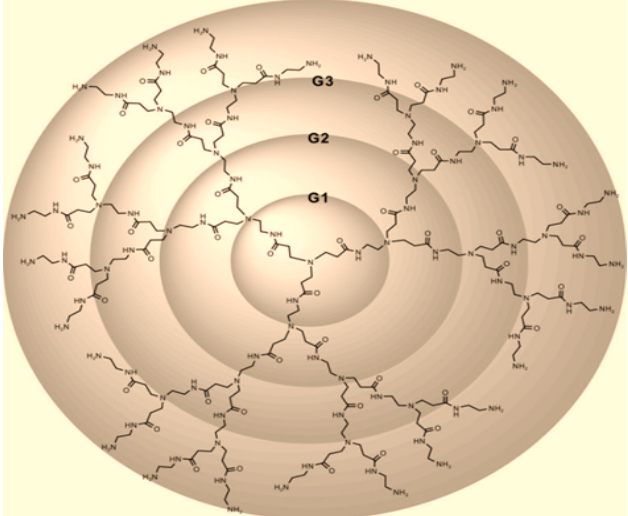
Figure 1. PAMAM dendrimer of generations G n with growth stages, PD 1 r 3 s